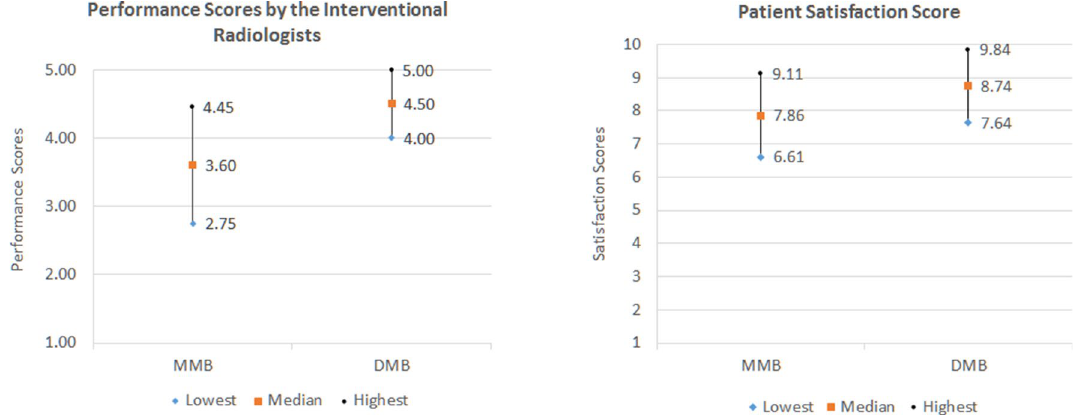
Figure 1. Performance scores by radiologists and patient satisfaction